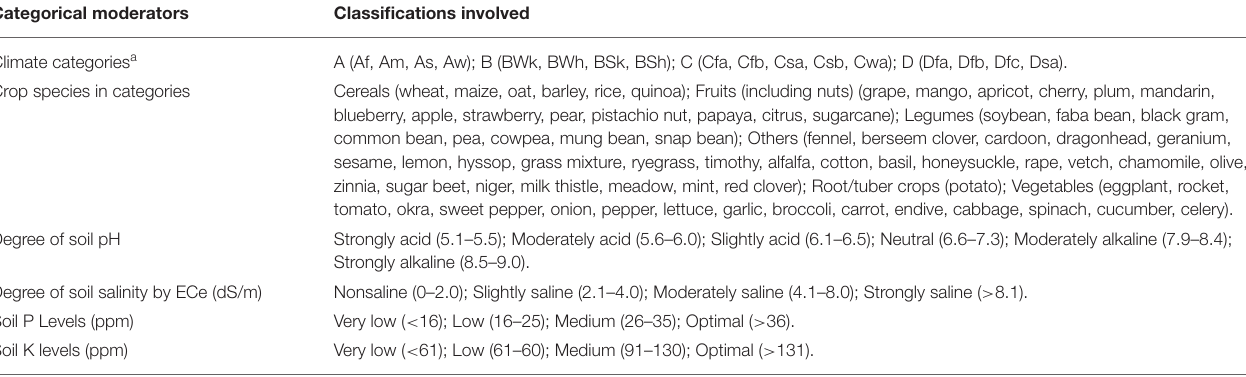
TABLE 1 | The description of classifications involved in categorical moderators. Categorical